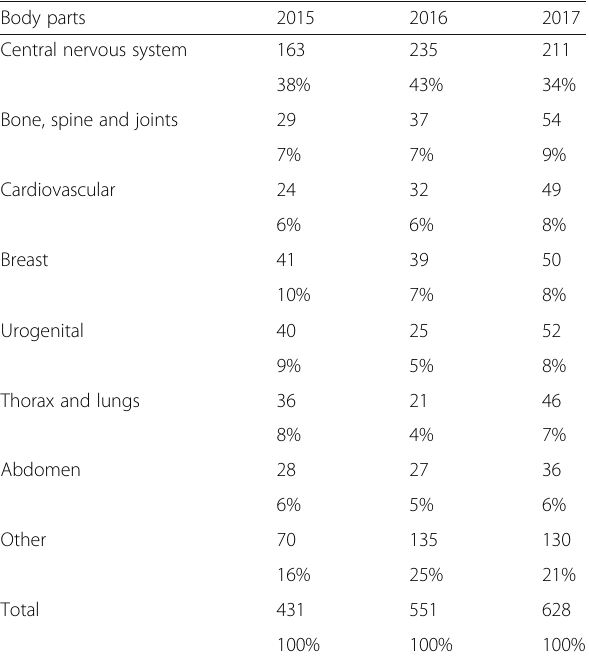
Table 2 Number of articles indexed on EMBASE stratified by radiology subspecialty/body